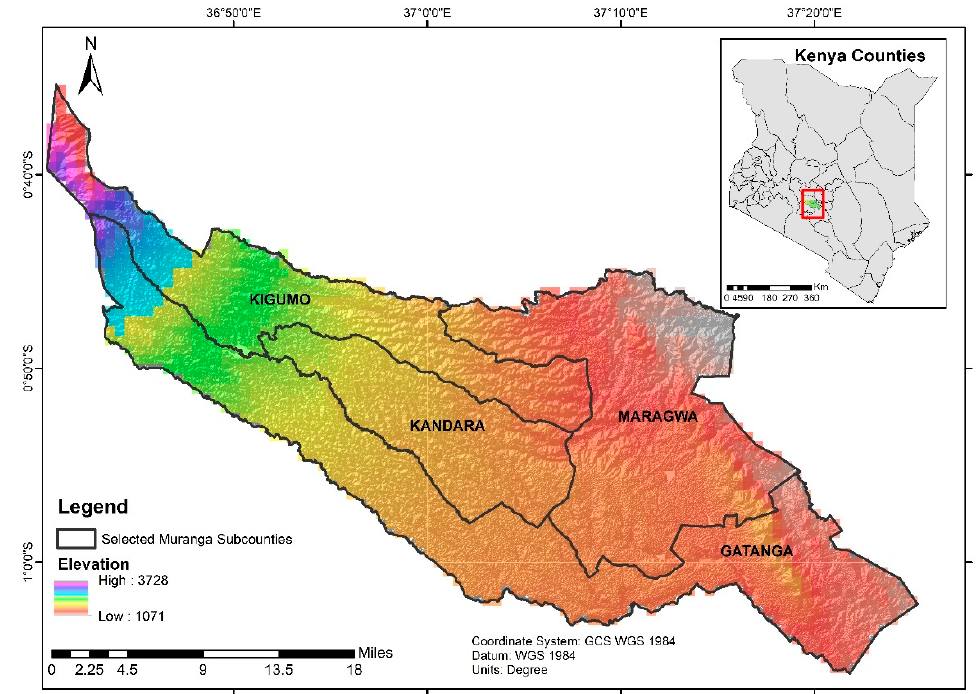
Figure 1. Location of the study area, Muranga county, Kenya. The background is the altitude range calculated from the Advanced Spaceborne Thermal Emission Reflection (ASTER) Global Digital Elevation Model (GDEM).